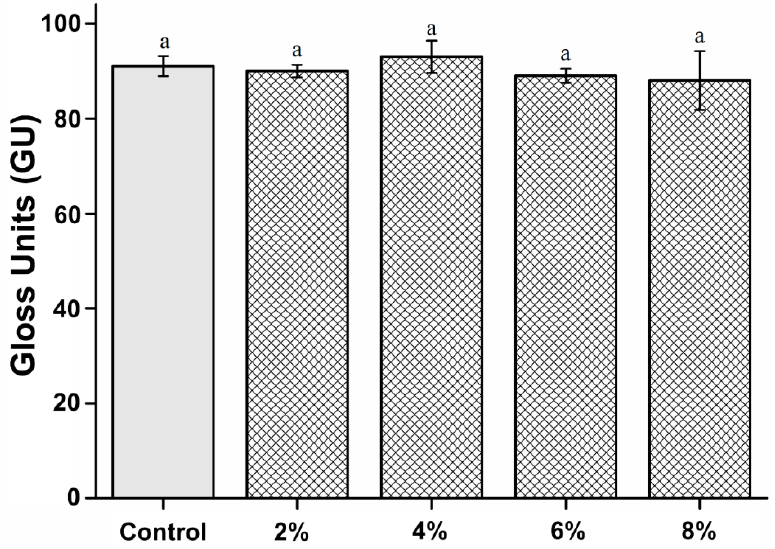
Figure 5. Comparison of surface gloss between the groups. “a” indicates that there is no statistically significant difference (P > 0.05).